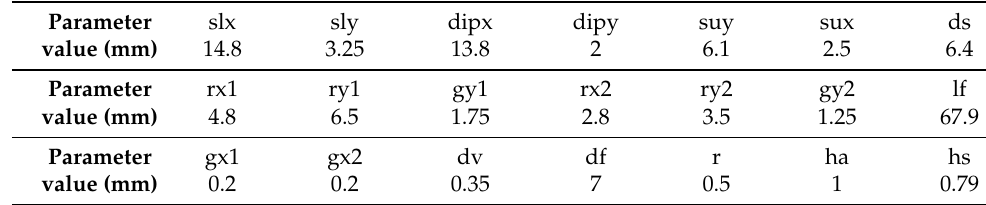
Figure 10. Simulated | S 11 | of analyzed filtering antenna for different short-circuit elements (see Figure 5b for the screw parameters) in comparison with the slot reference (the rest of the parameters are those shown in Table 2). Table 2. Parameters of the IM-GWG filtering